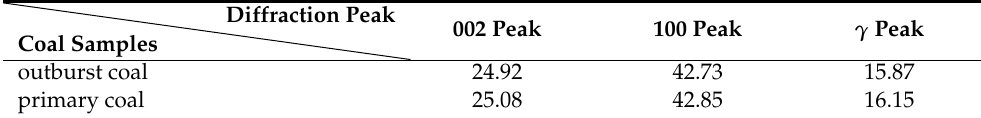
Table 4. Diffraction peak fitting of the main 2 θ parameters.